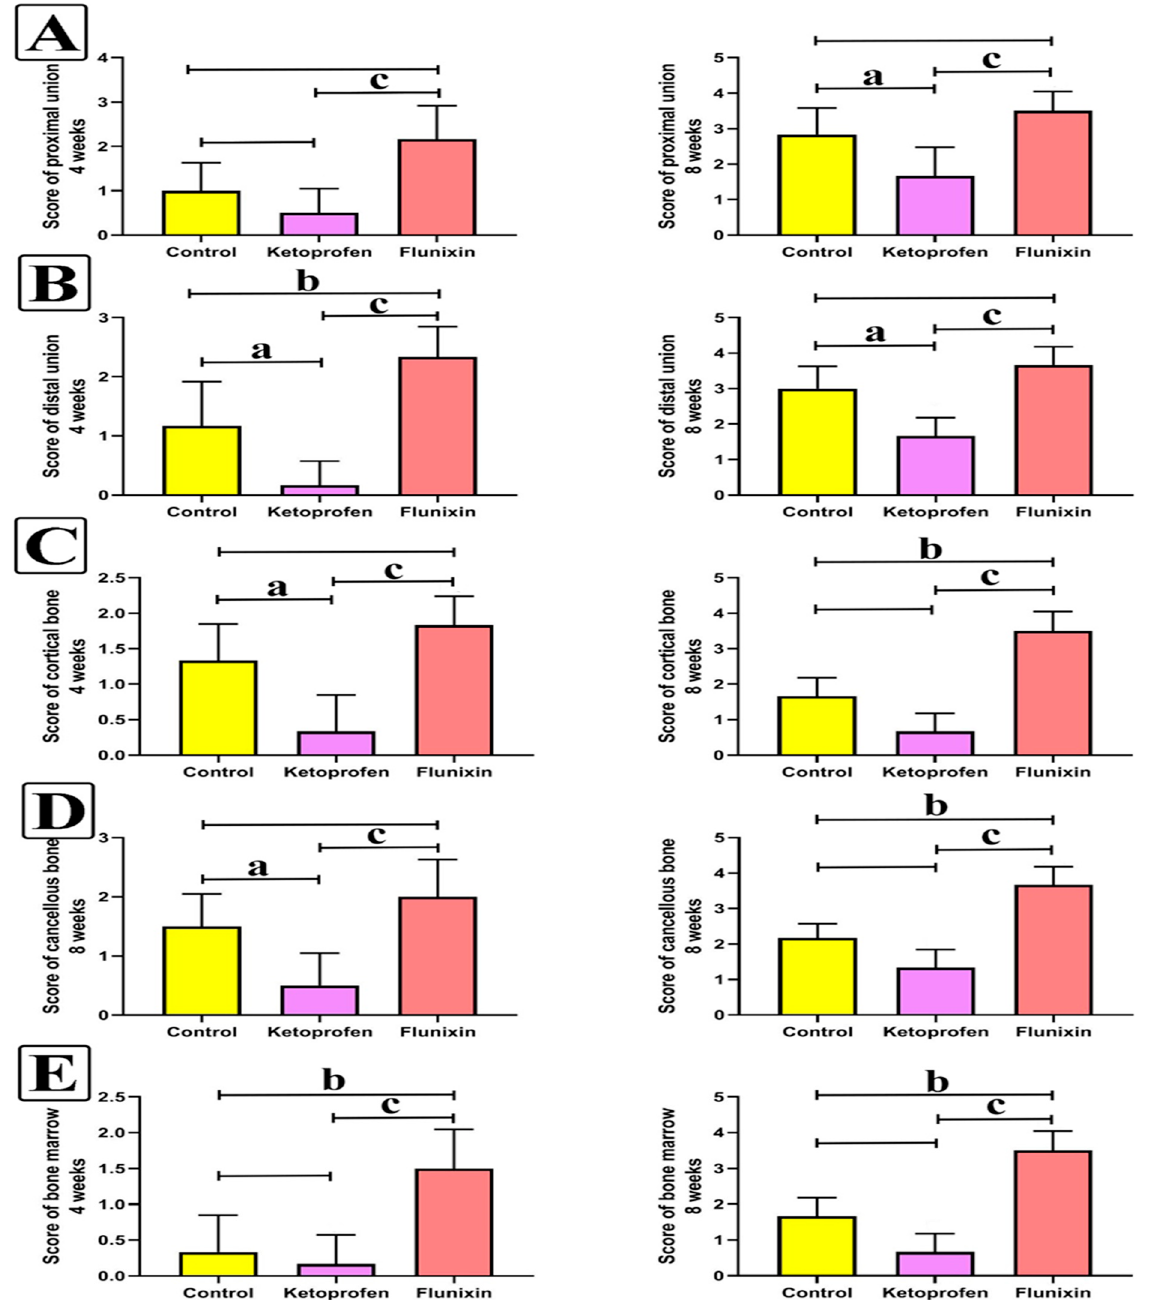
Figure 6. Histopathology statistics of H&E staining. ( A ): Score of the proximal union at 4 and 8 weeks. ( B ): Score of the distal union at 4 and 8 weeks. ( C ): Score of the cortical bone at 4 and 8 weeks. ( D ): Score of the cancellous bone at 4 and 8 weeks. ( E ): Score of the bone marrow at 4 and 8 weeks. Data are expressed as mean ± SD. Superscript letters indicate the significance level: a denotes the significant difference between the ketoprofen group and the control group, b denotes the significant difference between the FM group and the control group, and c: denotes the significant difference between the FM and the ketoprofen groups ( p < 0.05).